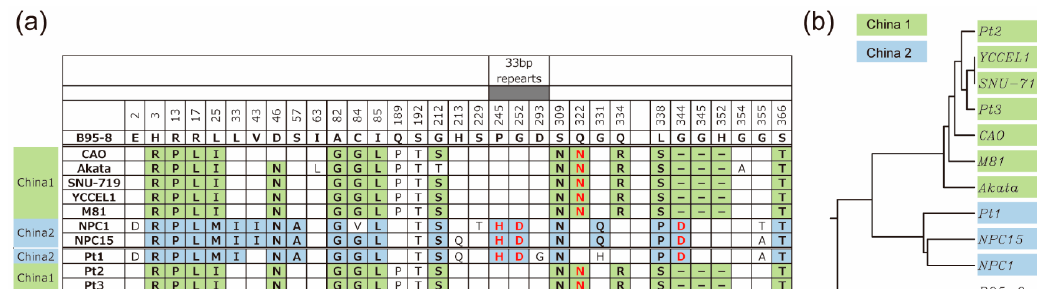
Figure 6. LMP1 amino acid sequences of EBV strains derived from Japanese NPC patients. ( a ) Varying amino acid sequences among LMP1 derived from Japanese EBV strains from NPC patients (Pt1, Pt2, and Pt3) and other representative EBV strains. Numbers correspond to amino acid positions within LMP1 B95-8 . Amino acid changes are denoted by letter changes; a dash represents a deletion. Strains harboring amino acid changes are shown in bold and shaded in different colors. Unique amino acids found in China 1 or China 2 are shown in red. The position of the 33 bp repeats is denoted at the top. LMP1 sequences were retrieved from GenBank. Accession numbers are as follows: B95-8, V01555; CAO, AF304432; Akata, KC207813; SNU-719, AP015015; YCCEL1, AP015016; M81, KF373730; NPC1, EF419184; NPC15, AY601321; Pt1, LC467962; Pt2, LC467963; Pt3, LC467964. ( b ) Phylogenetic tree constructed from the LMP1 amino acid sequences of Japanese NPC-derived EBV strains and other representative EBV